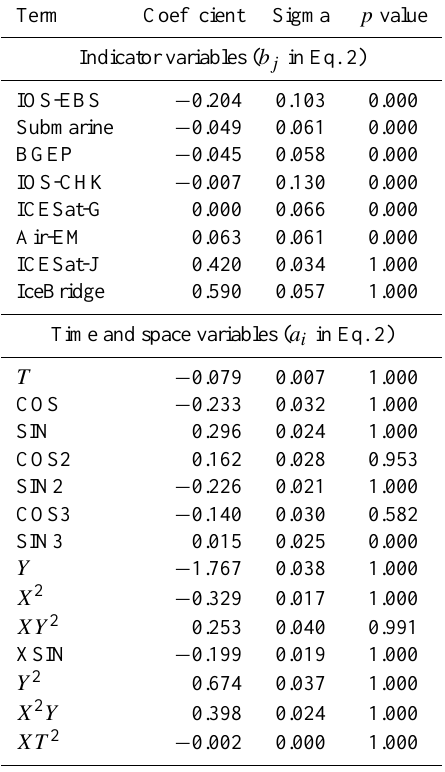
commonly used for ice volume estimates. The PIOMAS model (Version 2.1, Zhang and Rothrock, 2003) has an an- nual mean thickness trend of − 0.60 ± 0.04 m decade − 1 for the same area and time period, and thus its trend is quite con- sistent with that of the observations. In another observational Arctic Basin from CryoSat-2 data for 2 years, 2010 and 2011, estimates to compute a trend from 2003 to 2011. They found a thickness trend for fall and spring of 0.75 m decade − 1 .